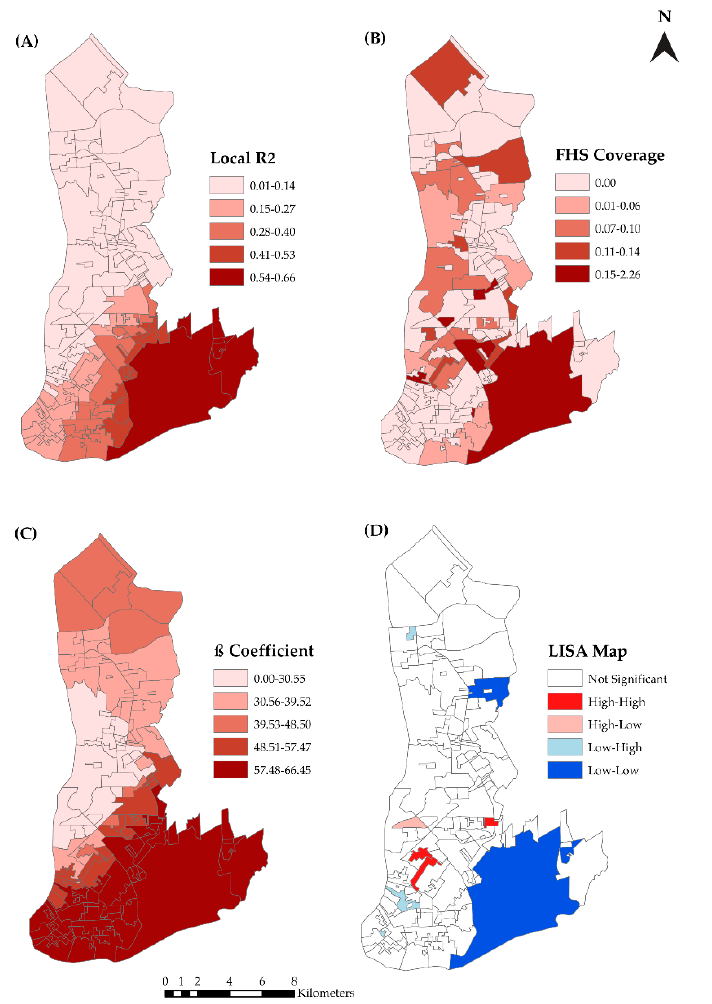
Figure 7. Spatial analysis of the social determinants of health and their association with HIV epi- demic in Belém, PA, Brazil